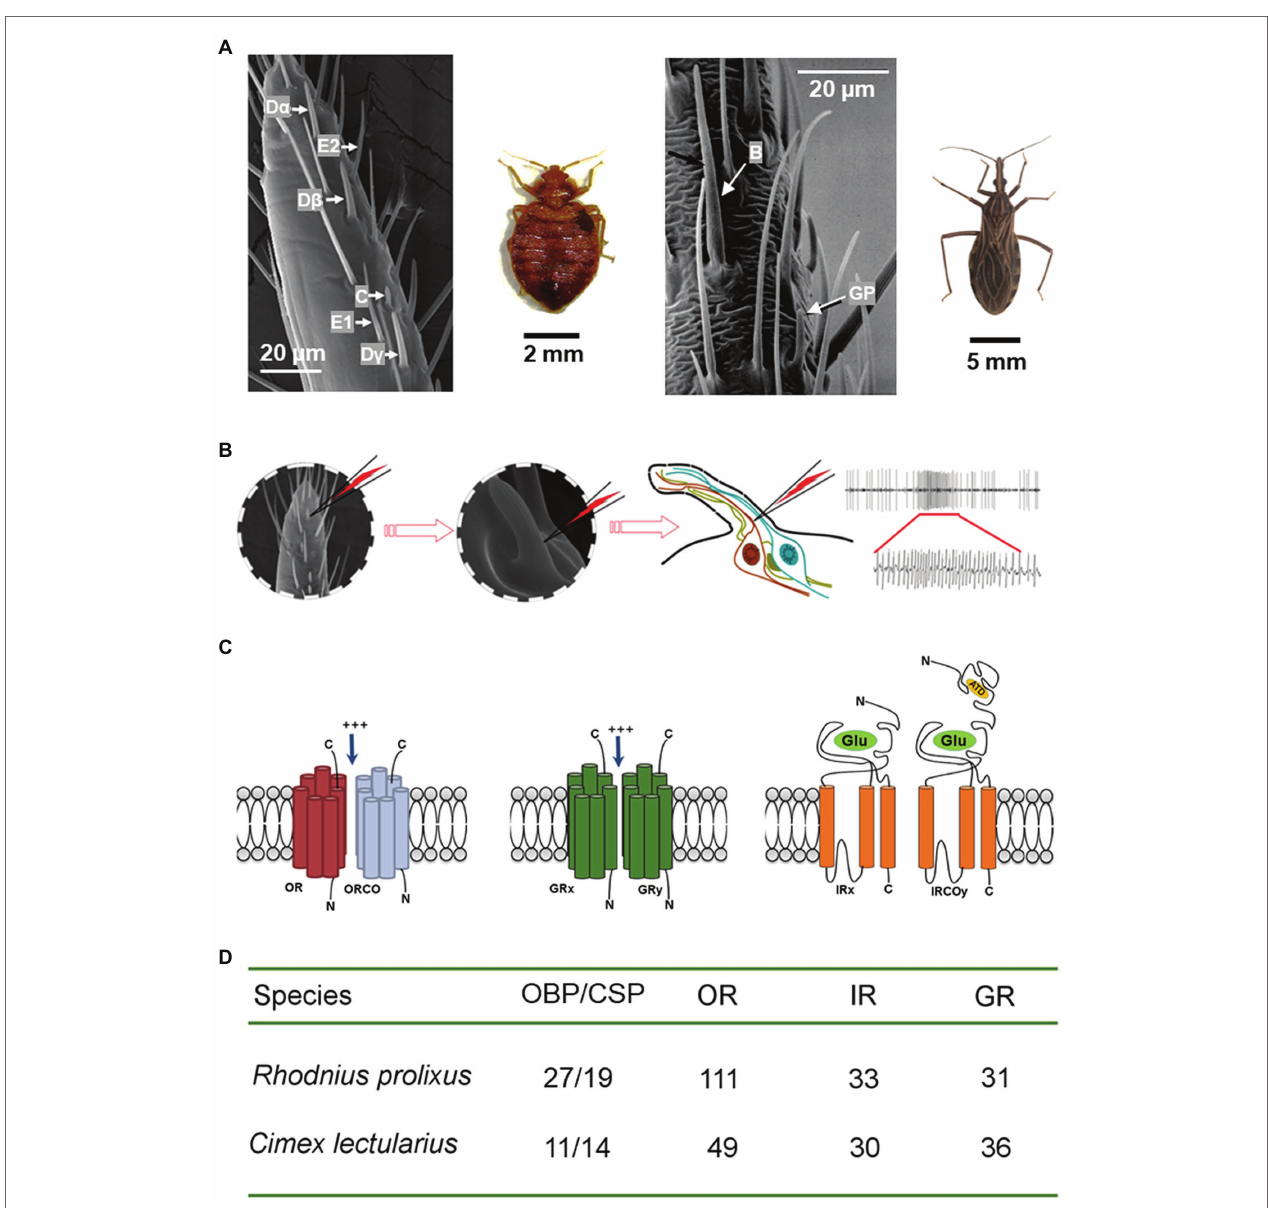
FIGURE 1 | Olfactory mechanism of the peripheral olfactory system in bed bugs and kissing bugs. (A) Scanning electronic microscope images show six functional types of olfactory sensillum (D α , D β , D γ , E1, E2, and C) for bed bugs (left; Liu and Liu, 2015) and two types (Basiconica and grooved peg) for kissing bugs (right; adapted from Guerenstein and Guerin, 2001, with the permission from Dr. Guerin). (B) The olfactory receptor neurons housed in each olfactory sensillum are responsible for detecting the attractive cues and increasing the firing frequency of the action potentials. Left: one section of a bed bug antennae; middle: a single sensillum is shown at high magnification (x720); right: depiction showing that the recording tungsten electrode is inserted into the shaft of a sensillum to complete the electrical circuit and to extracellularly record the olfactory receptor neuron potentials. (C) Schematic diagrams of the structures of three olfactory receptors (OR/ ORCO, GR, and IR/IRCO) expressed in the membranes of the neuron dendrites that are the molecular targets for host cues. (D) The total number of odorant binding proteins and olfactory receptors (OR/ORCO, GR, and IR/IRCO) identified in the genomes of C. lectularius and R. prolixus